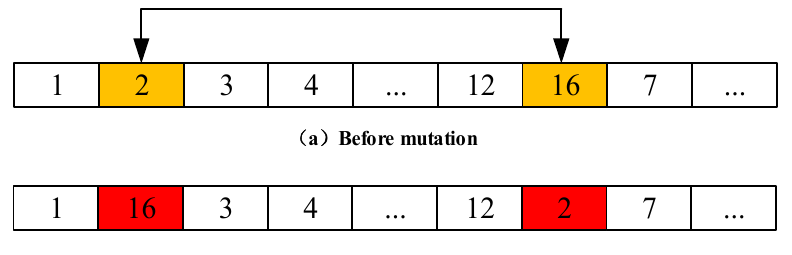
Figure 9. Crossover operator.